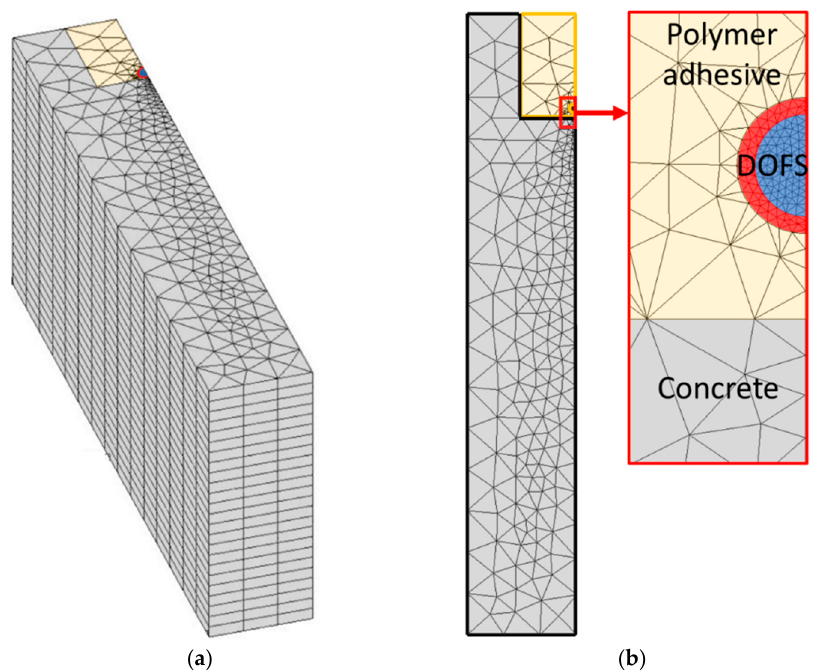
Figure 2. Finite element mesh of ( a ) the 3D geometry and ( b ) the cross-sectional view of the system.